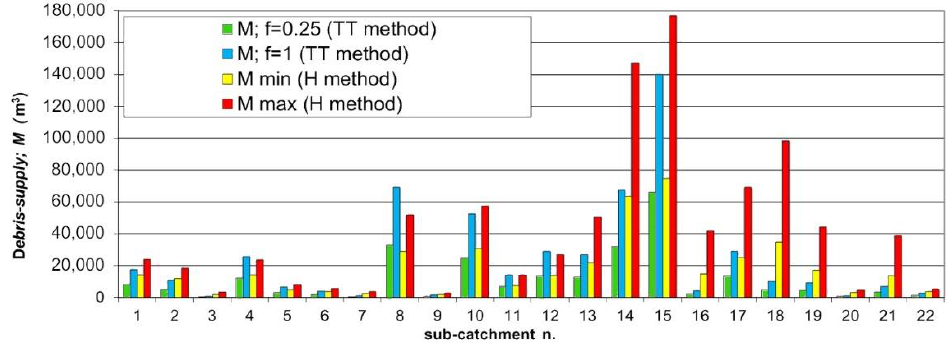
Figure 13. A comparison between max–min debris-supply values, estimated by the Hungr [61] method (H method) and the debris-supply values computed using “recurrence interval factors” 0.25 and 1, respectively by the Tropeano and Turconi [60] method (TT method).